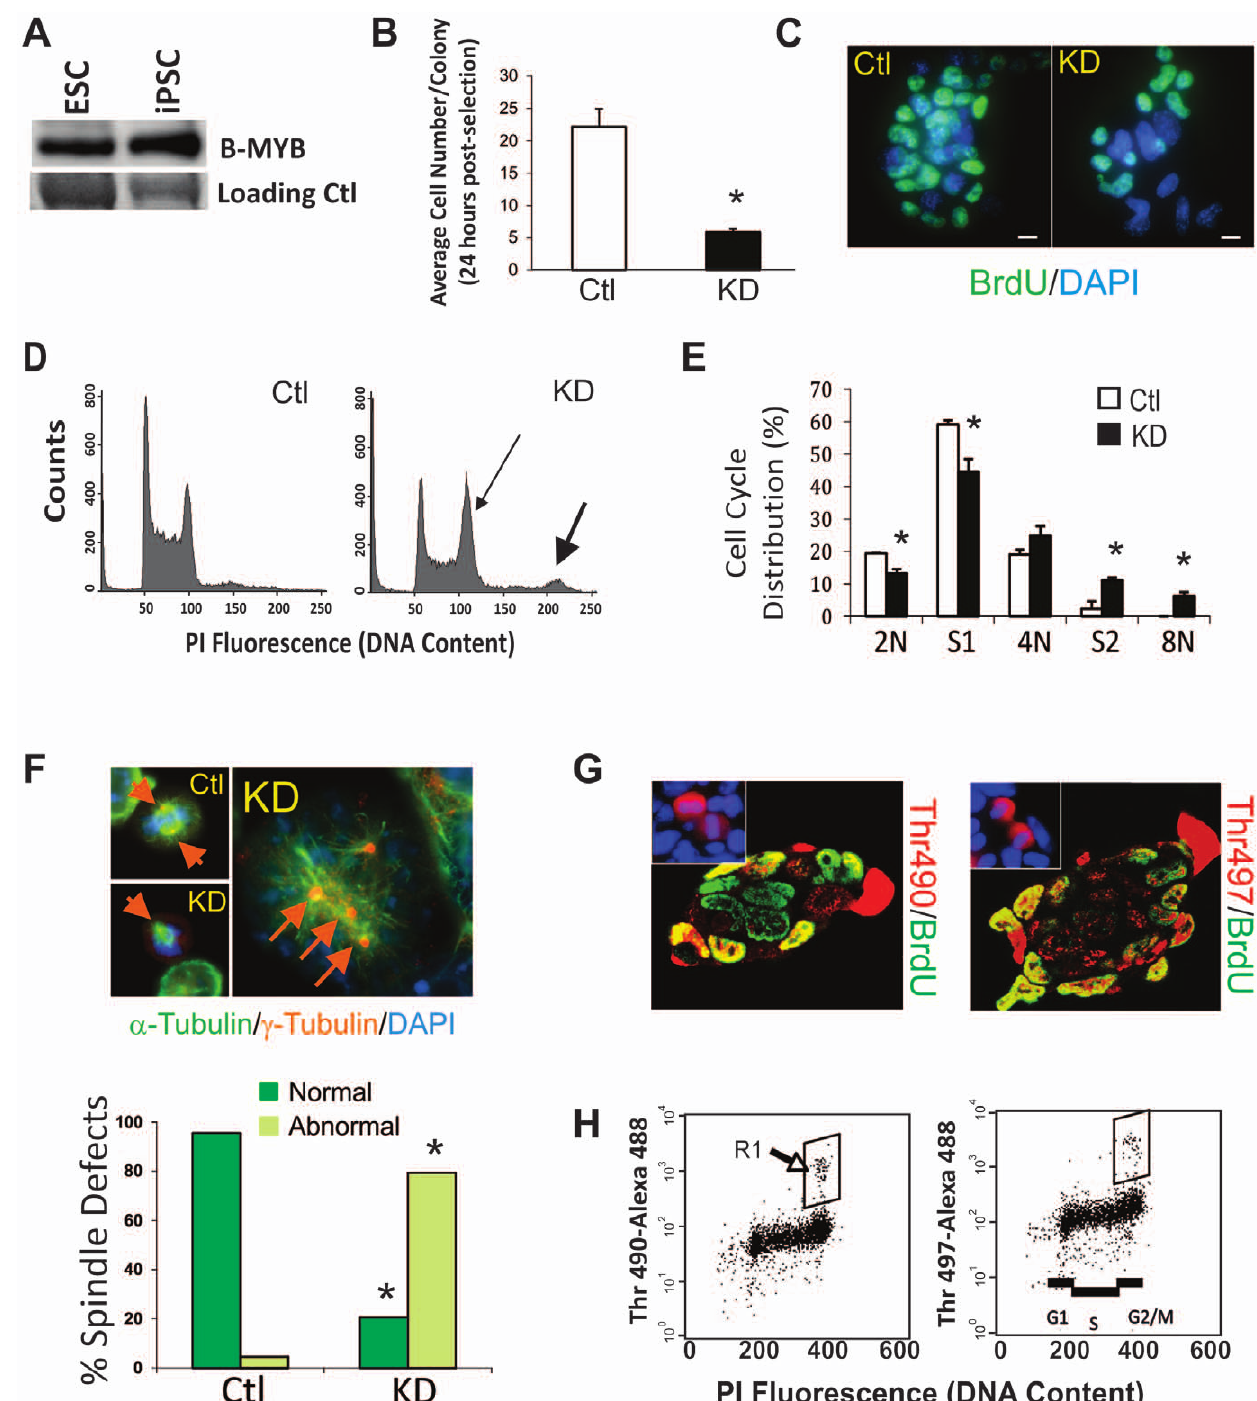
Figure 1. B-MYB function and phosphorylation in pluripotent stem cells. A) Western blot showing presence of B-MYB in ESCs (R1) and iPSCs (2D4). B) Graphic representation of the average number of cells present within individual ESC colonies (n=40 colonies/group) 48 hours after nucleofection with control or targeting shRNA1 vectors to B-MYB. C) Typical image of pulsed BrdU incorporation in control and B-MYB deficient ESCs, showing decreased BrdU incorporation in B-Myb knockdown (KD) cells. D) DNA content measured by flow cytometry of non-synchronized fixed ES cells stained with propidium iodide after nucleofection with shRNA constructs. At 48 hours post-nucleofection, including 24 hours of selection with puromycin, a shift in the DNA content to a G2/M prevalent and aneuploid (8N) state (see arrows in inset) can be detected. E) Quantification of the cell cycle distributions following knockdown (KD) of B-MYB. The number of cells in S phase decreased concomitant to an increase in the number of cells in G2/M relative to controls and a significant increase in octoploidy (8N). F) Representative mitotic cells stained with DAPI (blue), a -tubulin (green) and c -tubulin (red) are shown. In these experiments, mitotic spindle and centrosome defects are readily observed in cells lacking B-Myb. A quantitative assessment of spindle defects detected in B-Myb deficient cells (n=3, 100 cells/group) is shown in the graph below. G) Images of immunostained ESC colonies with antibodies specific for phosphorylated forms of B-MYB. It is noteworthy that all mitotic cells show phosphorylation at Thr490 or Thr497.